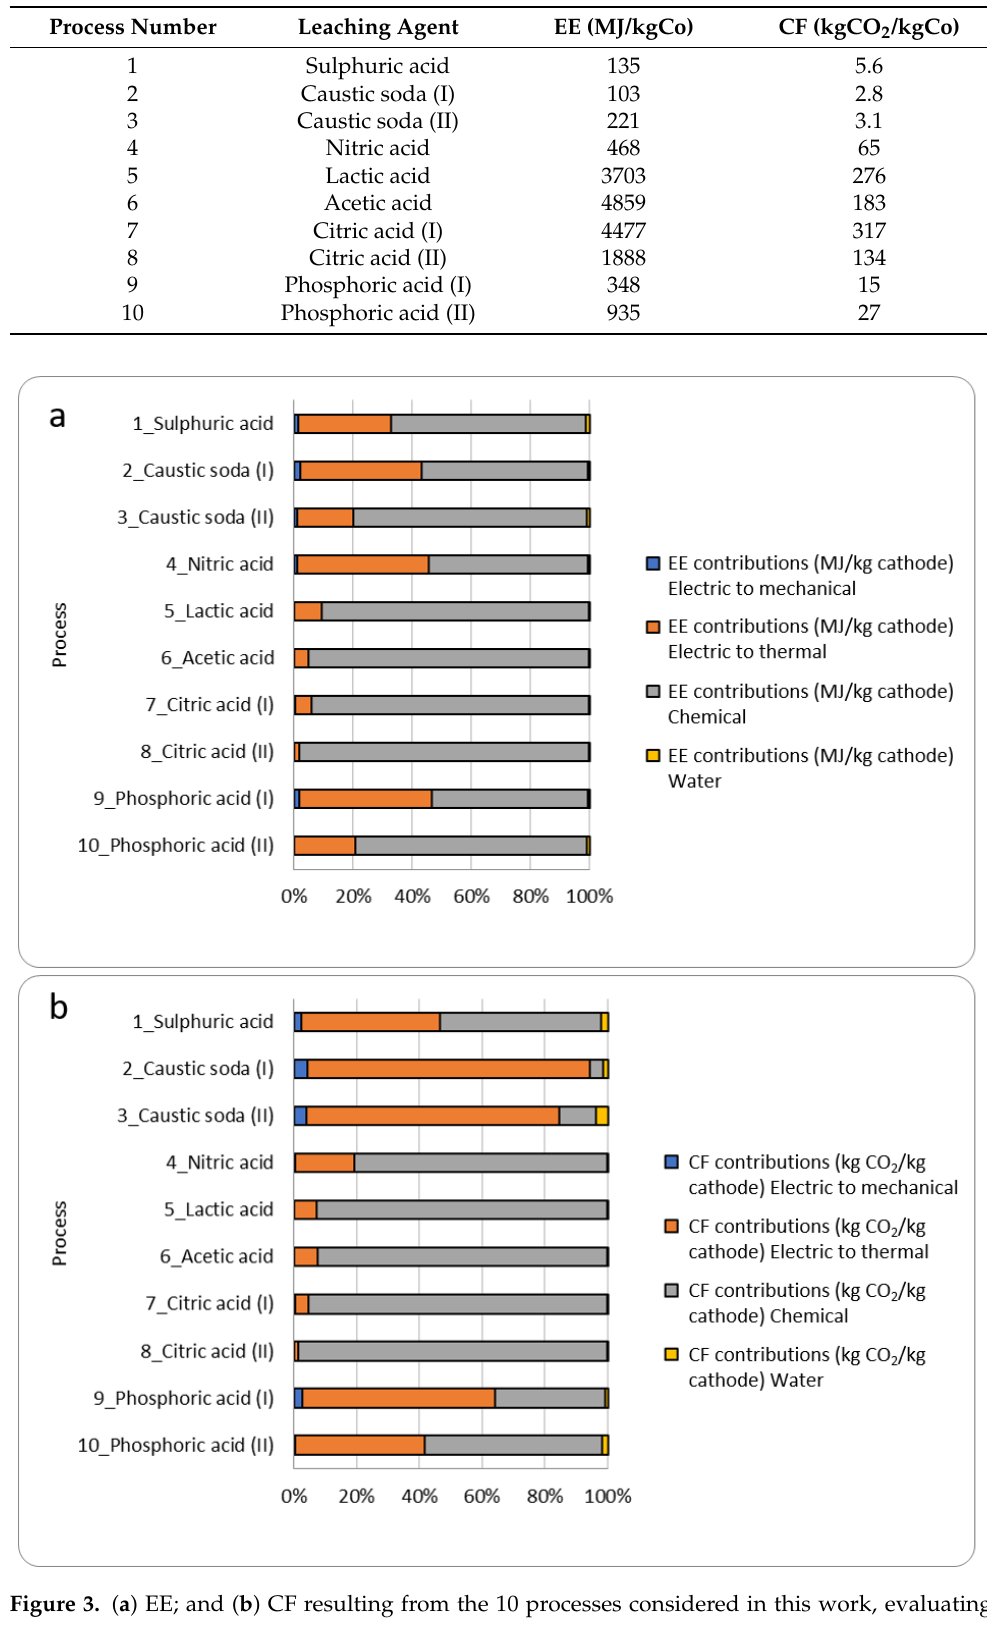
Table 2. EE and CF evaluated for all Co extraction processes considered in this